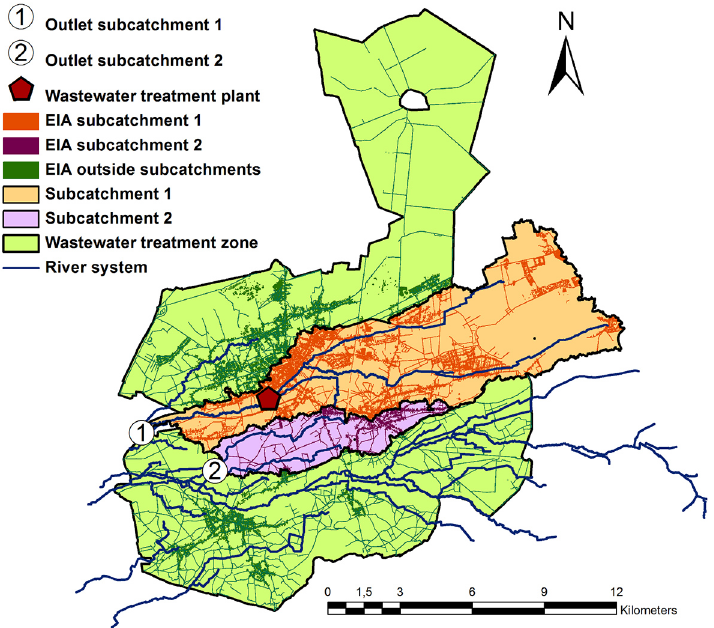
Fig. 3. Example on the calculation of the upstream areas. The WWTP discharges into subcatchment 1 (orange colored). Therefore the EIAs within the WWCR, but outside subcatchment 1 (green and purple colored), are included in the upstream area of subcatchment 1. As a result the area of this subcatchment increases by 404ha of impervious area or by 5.1% of the total area. Because the EIA is removed from subcatchment 2 (purple color), the area of subcatchment 2 decreases by 69ha or 4.3% of the total